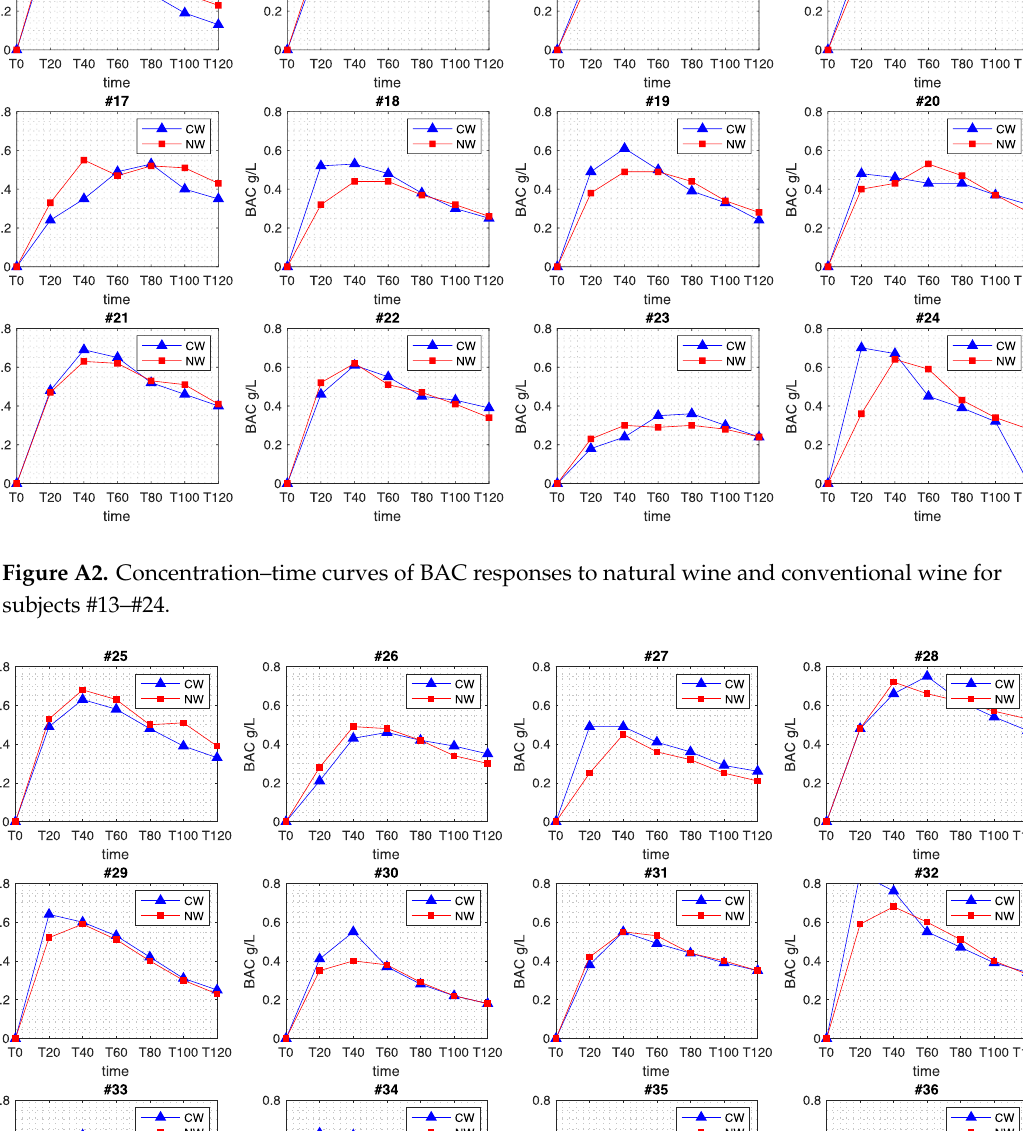
Figure A3. Concentration – time curves of BAC responses to natural wine and conventional wine for subjects #25 – #36.